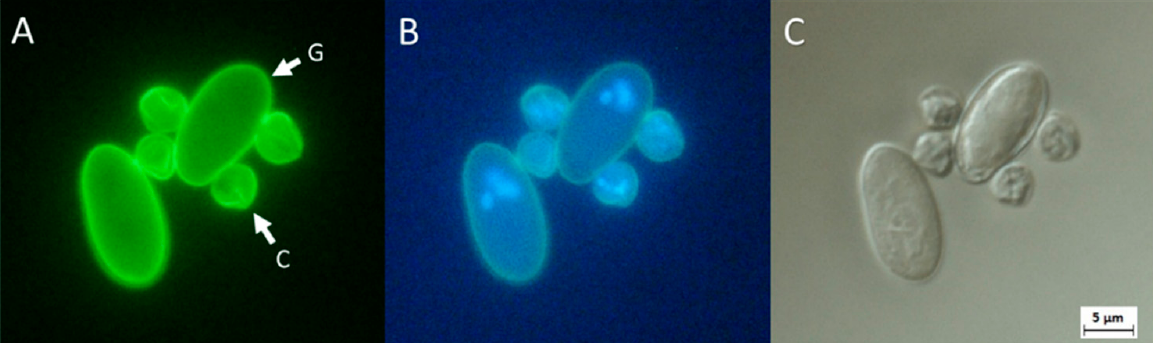
Figure 2. Microscopic observation of Cryptosporidium spp. and Giardia spp. Cells 4–6 µm in diameter in these pictures belong to the Cryptosporidium genus while cells 8–18 µm long by 5–15 µm wide are identified as Giardia spp. ( A ) A bright green fluorescence can be seen on the cells’ periphery with the use of two antibodies specific to each parasite linked to FITC. ( B ) The DAPI marker allows the identification of nuclei within the cells. Cryptosporidium spp. is known to possess four nuclei in its oocyst configuration. Giardia spp. cysts contain two cells that are still linked, each of which has two nuclei. Therefore, two to four nuclei are expected to be observed according to the orientation of the cyst. ( C ) Under differential interference contrast, Cryptosporidium spp. oocysts can be seen as spher- ical structures with rough edges. Giardia spp. cysts have an irregular shape most often perceived as ovoid.